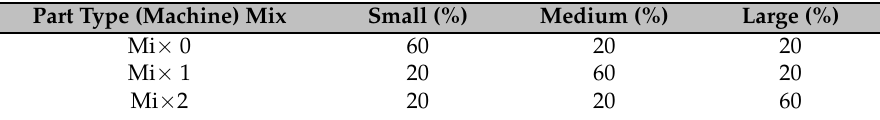
Table 2. Constituents of part type and machine mixes.